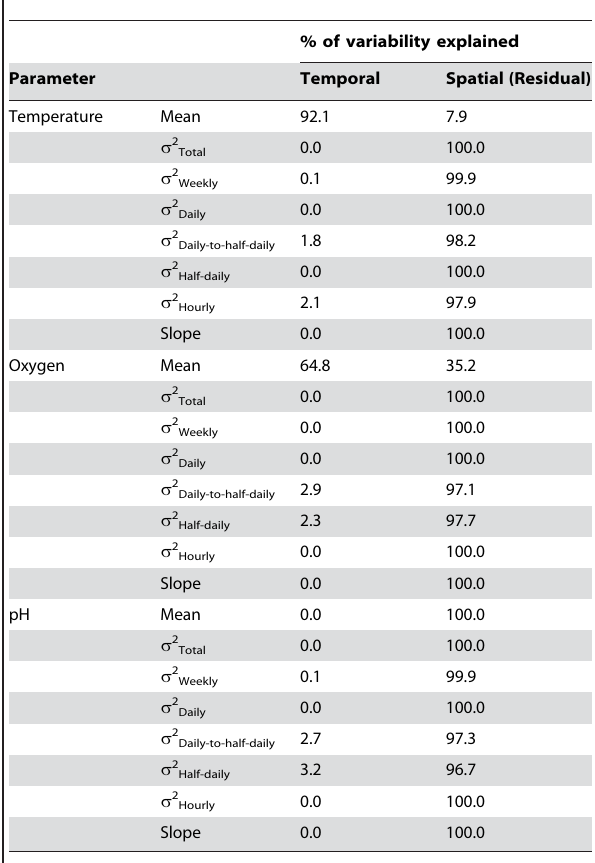
Table 1. Variance components analyses